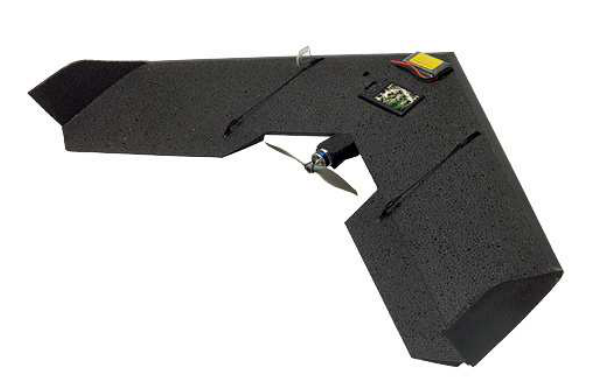
Figure 2. The Sensefly Swinglet